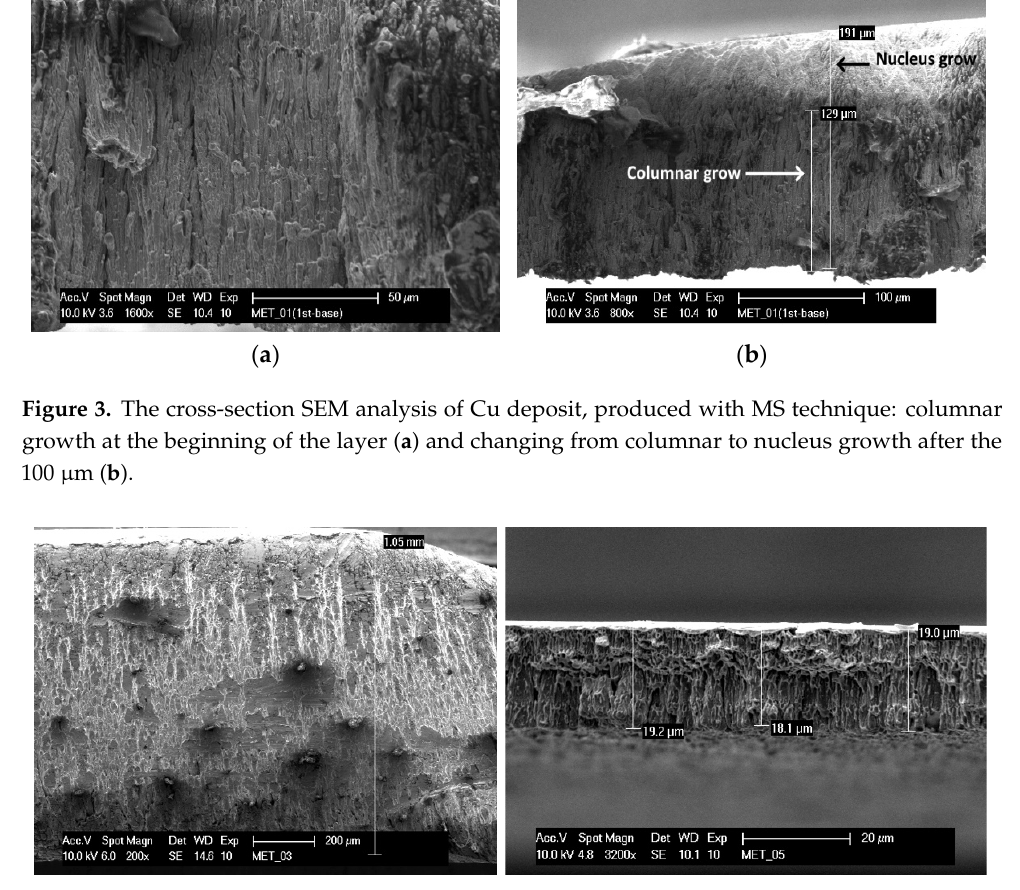
Figure 4. The cross-section thickness evaluation of MS deposition ( a ) and DS deposition ( b ).